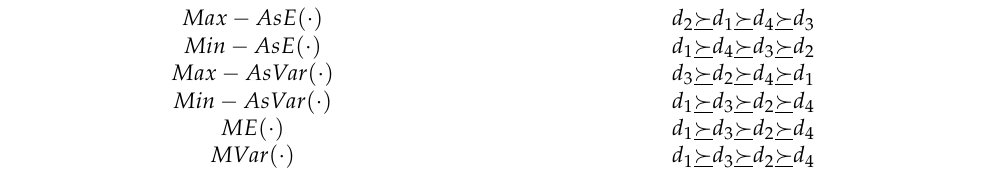
Table 7. Ranking of MADM alternatives by the F -associated and monotone expectations and variations. Max − AsE ( · )